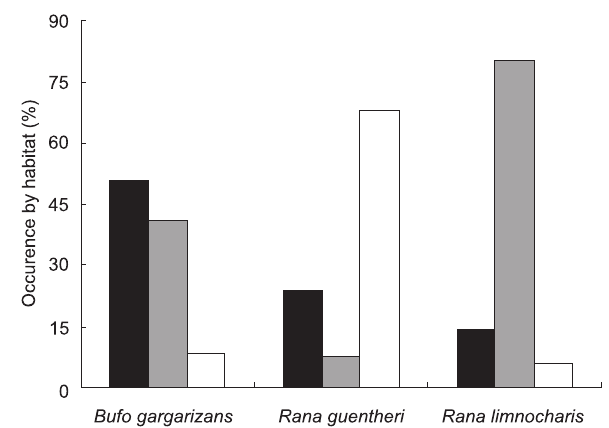
Figure 1. Habitat use (%) by Bufo gargarizans , Rana guentheri , and Rana limnocharis . (  ) small road close to shrub or pre-harvested corn, (  ) bare surfaces or short grass in the middle of habitat, (  ) bare surfaces or short grass at habitat